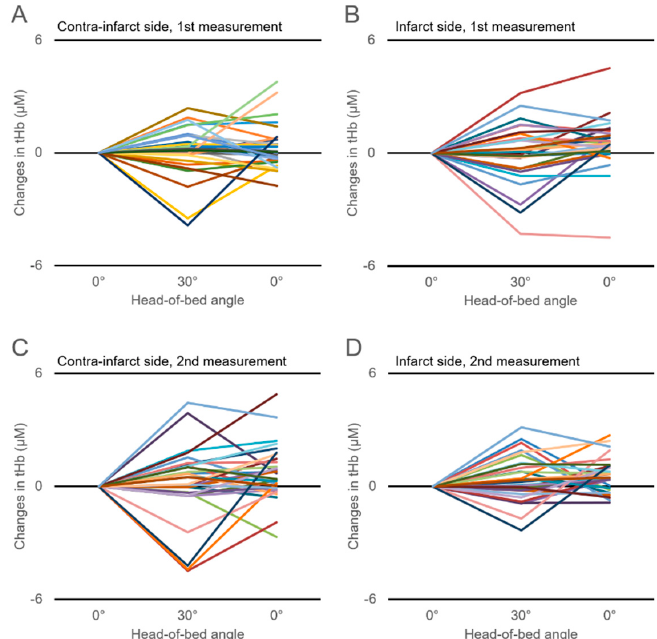
Figure 1. Time-series changes in the cerebral total hemoglobin (tHb) concentration in response to head-of-bed manipulation (from 0° to 30°) for 30 participants within 72 h of onset of acute ischemic stroke (AIS) (first measurement) on the contra-infarct (contralateral) side ( A ) and infarct side ( B ) and those measured 7–10 days after onset of AIS (second measurement) on the contra-infarct side ( C ) and infarct side ( D ).